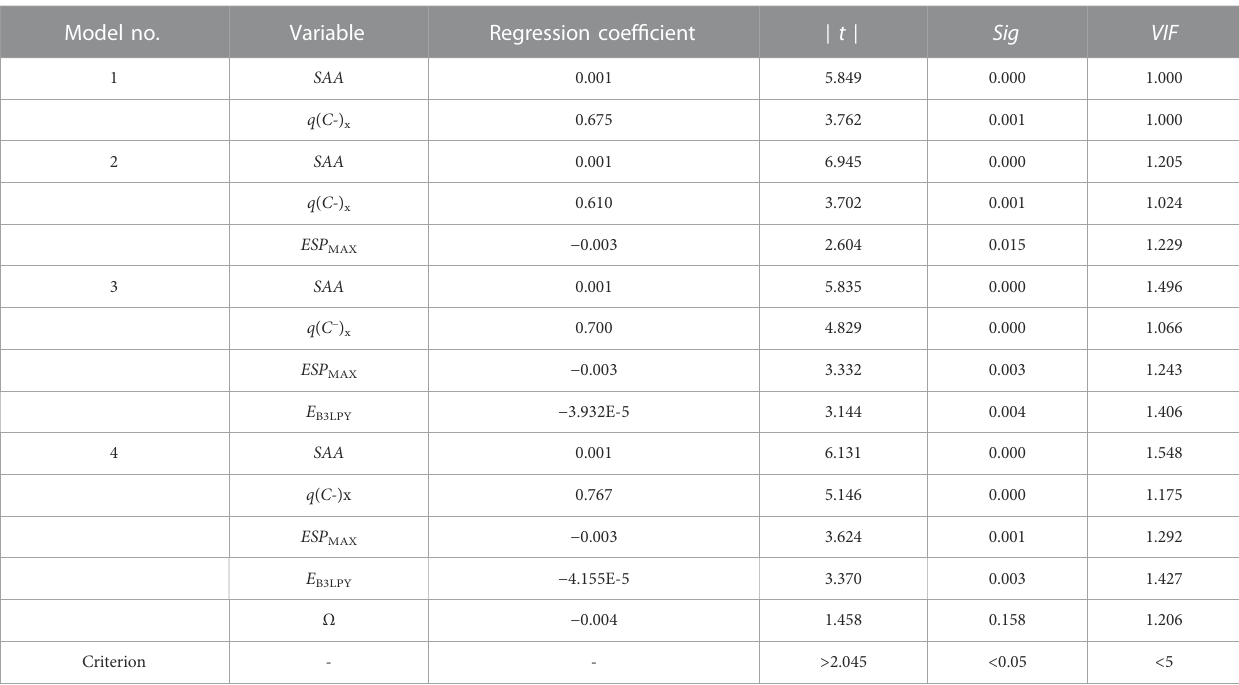
TABLE 4 Statistical data of the QSAR models at pH = 10. Model